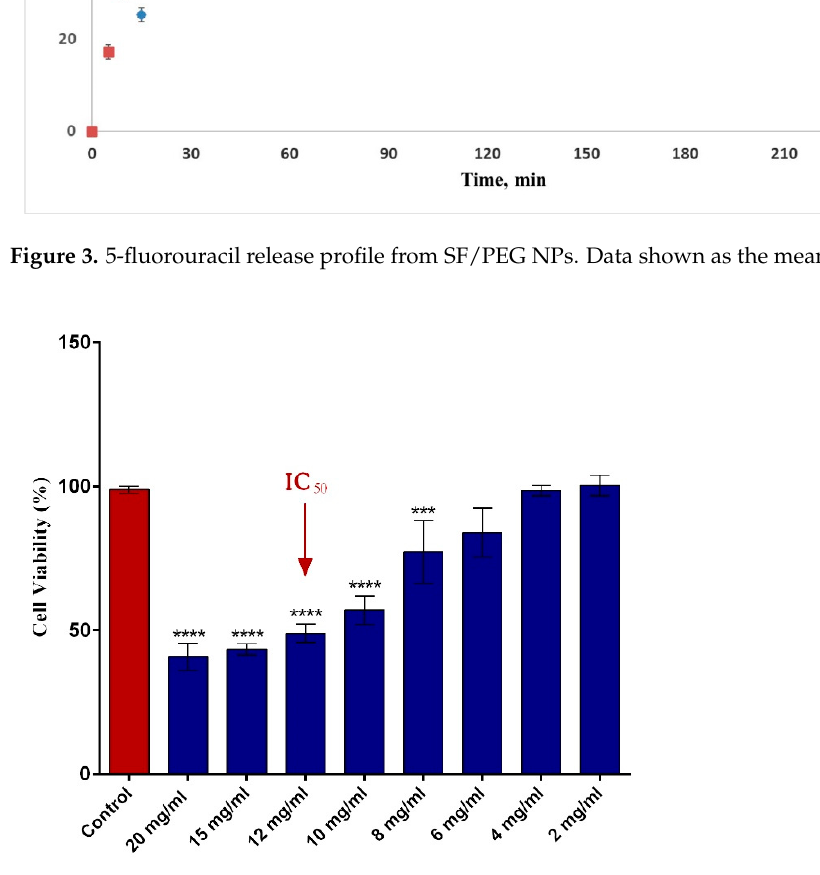
Figure 3. 5-fluorouracil release profile from SF/PEG NPs. Data shown as the mean ± SD (n = 3).